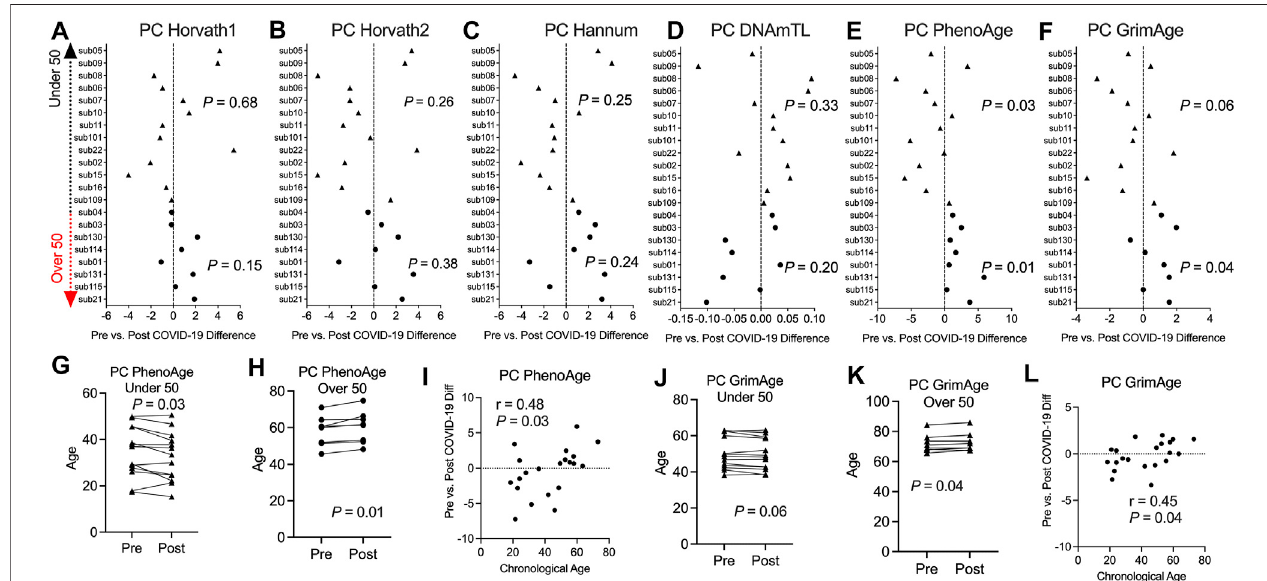
FIGURE 4 | Divergence in principal component-based DNAmPhenoAge and GrimAge mortality risk increased based on age related to COVID-19 (A – F) . Plots displayingthechangeinprincipalcomponent-basedepigeneticclockageestimatesinindividualspre-vs.post-COVID-19strati fi edbyage.Trianglesdisplayparticipants less than 50 years of age and circles display participants over 50 years ofage (G,H) . Plots displaying the change in principal component-based PhenoAge in individuals under and over 50 years of age pre- vs. post-COVID-19 (I) . Correlation plot of chronological age and the change in PCPhenoAge pre- vs. post-COVID-19 (J,K) . Plots displaying the change in principal component-based GrimAge in individuals under and over 50 years of age pre- vs. post-COVID-19 (L) . Correlation plot of chronological age and the change in PCGrimAge pre- vs. post-COVID-19.